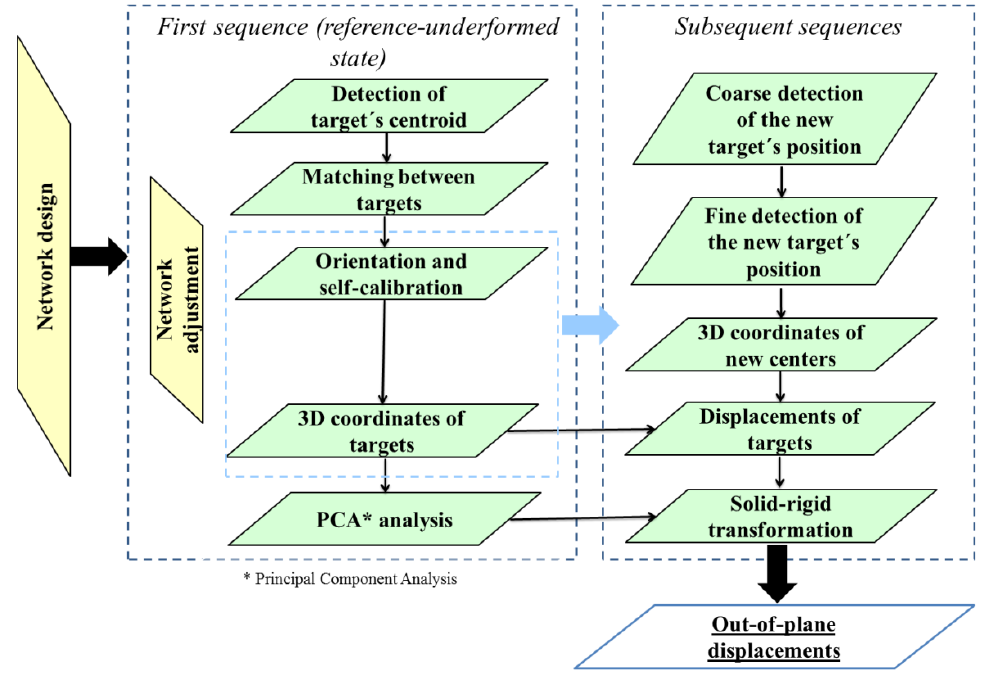
Figure 3. Proposed photogrammetric workflow developed to evaluate the out-of-plane behavior of the masonry wall during the quasi-static cyclic test.